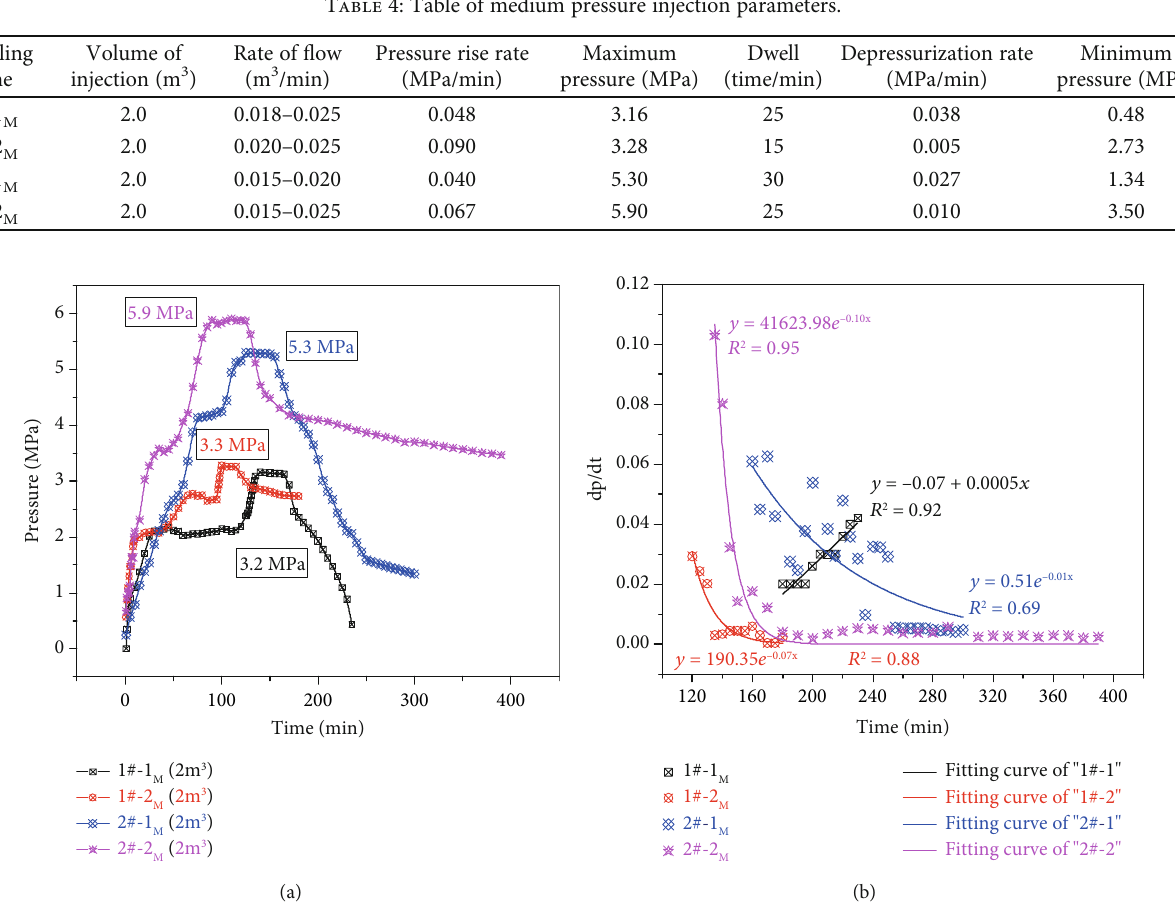
Figure 6: Variation of ori fi ce pressure during medium pressure